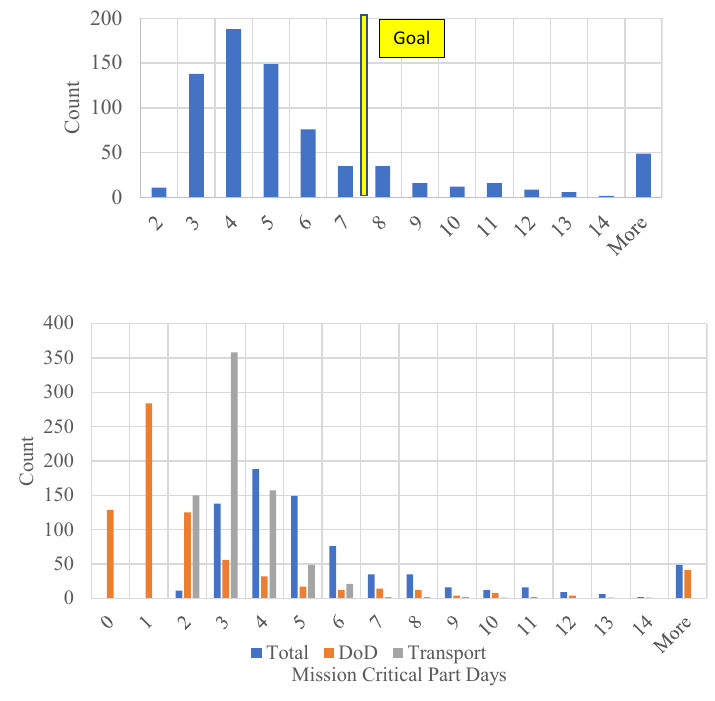
Figure 5. Total mission